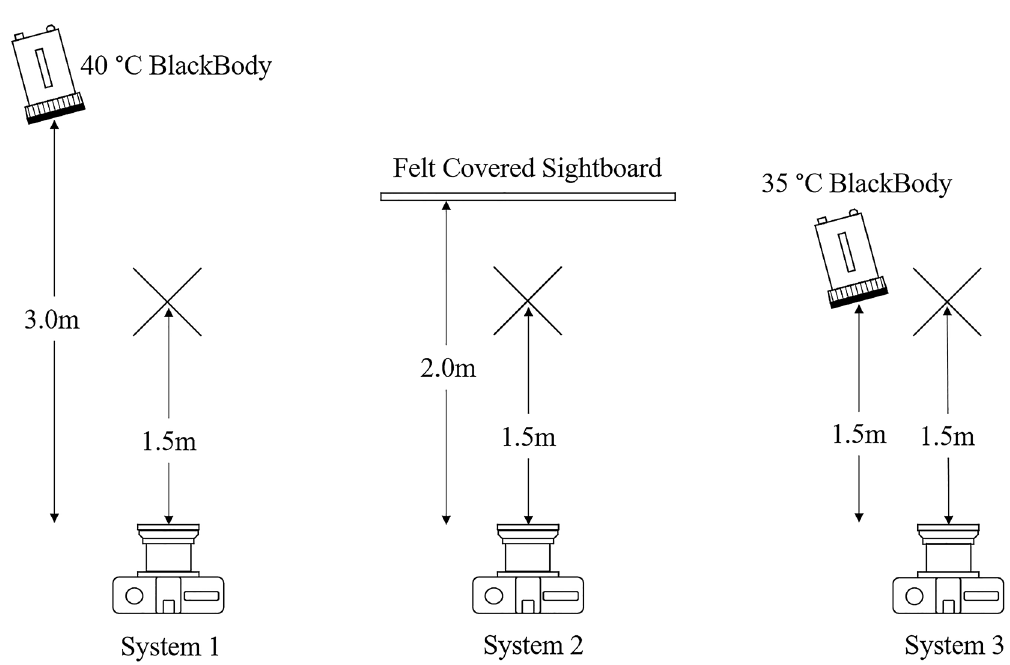
Figure 1. Experimental setup of the three IRT systems. In each case, the location of the subject being measured is indicated by a